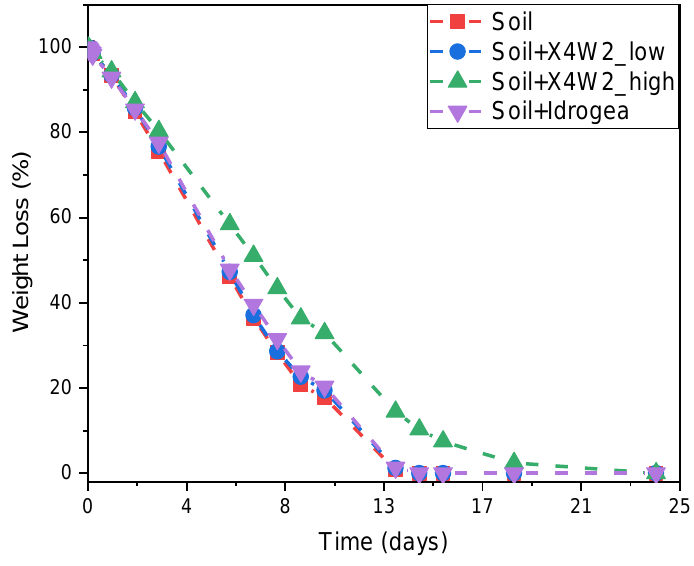
Figure 8. Water retention of the soil with X4W2 hydrogels and Idrogea.